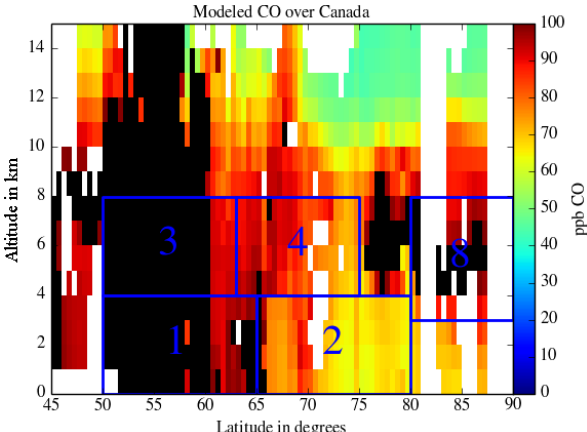
Figure 7. Latitudinal cross section of the modeled CO mixing ratio in ppbv over Canada for the measurement of spatiotemporal distri- bution from the June–July 2008 WRF-Chem simulation. The blue boxes correspond to the regions where data are averaged for dis- cussing vertical and latitudinal gradients in Table